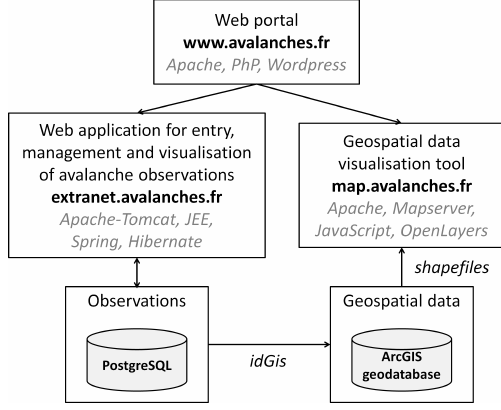
Figure 6. Main components of the information